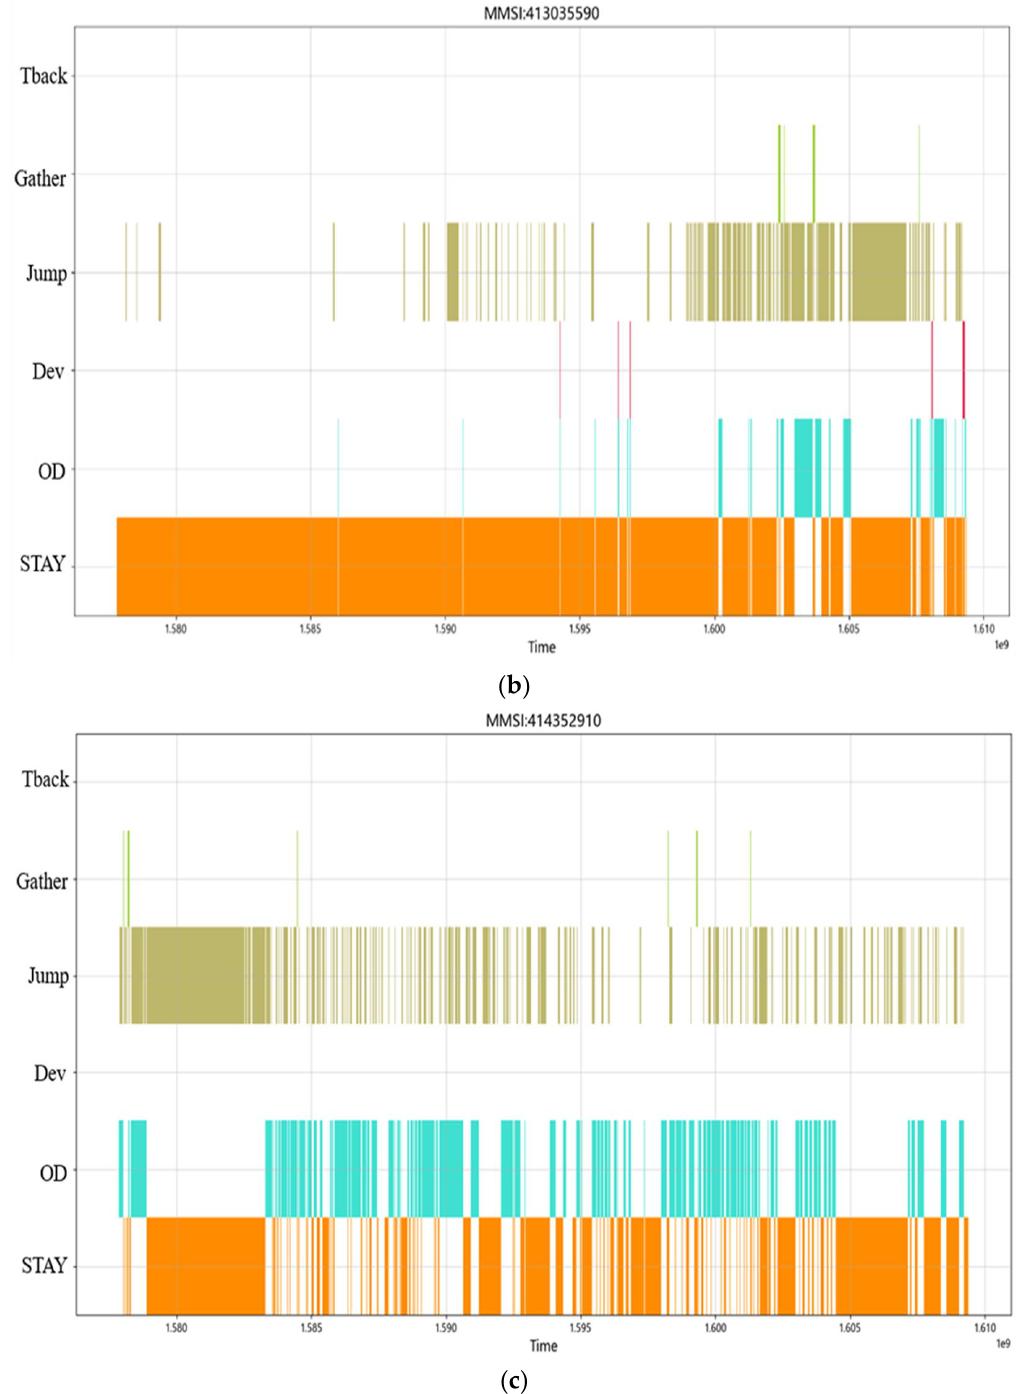
Figure 14. ( a ) Visualization of complex behavior of the first suspicious ship; ( b ) Visualization of complex behavior of the second suspicious ship; ( c ) Visualization of complex behavior of the third suspicious ship.